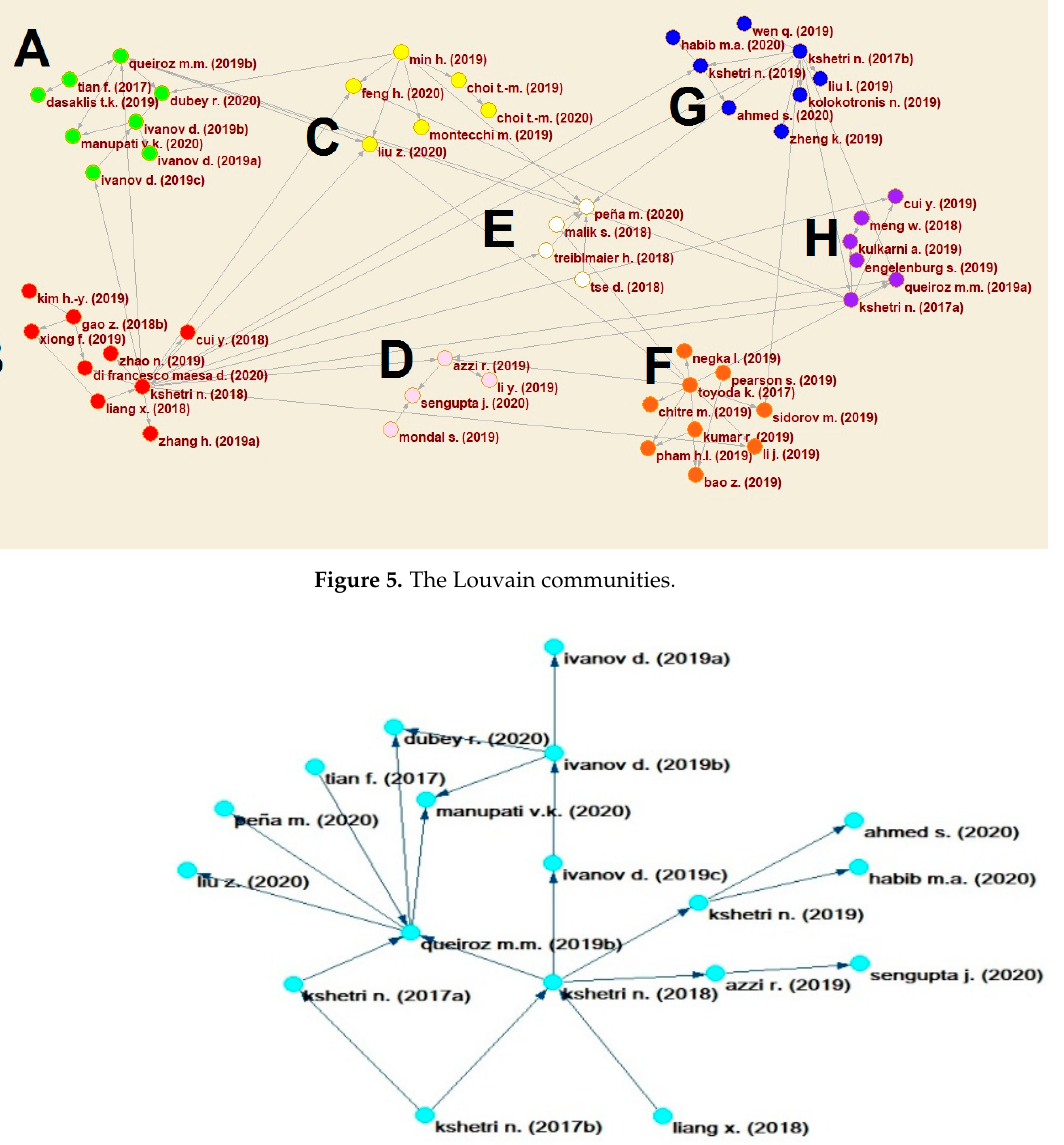
Figure 6. Main path biggest connected component of the citation network. Table 1. Analysis of the most relevant documents belonging to the main path.